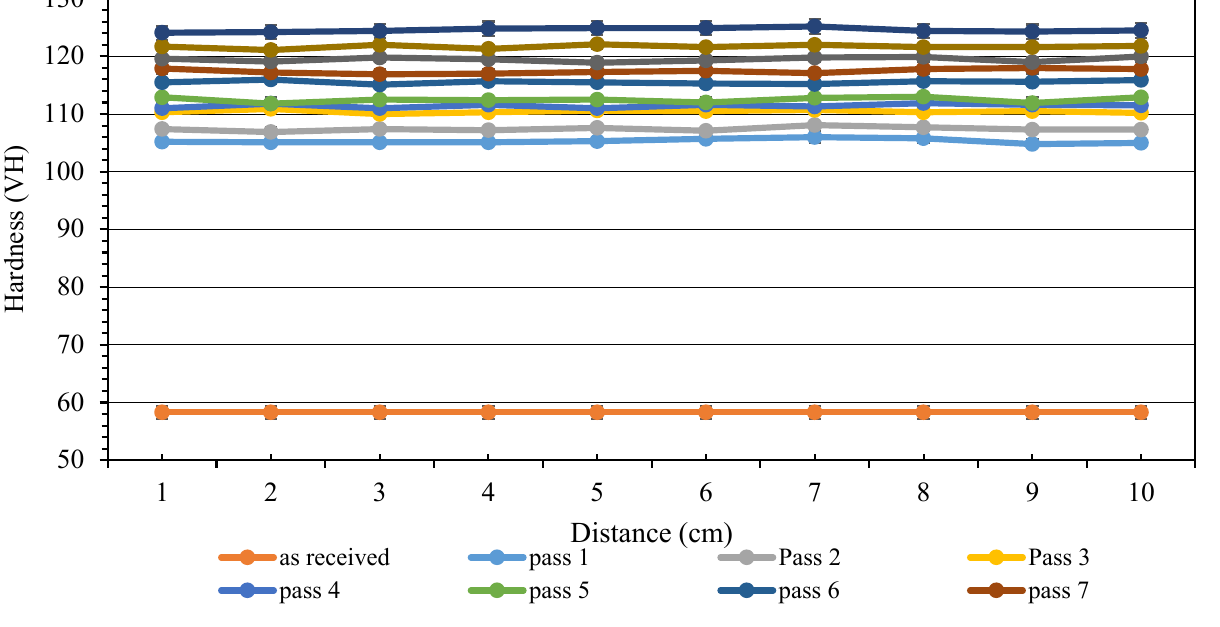
Figure 13. Distribution of Vickers microhardness along the direction on Figure 12 for the as annealed and modified-CSP samples.